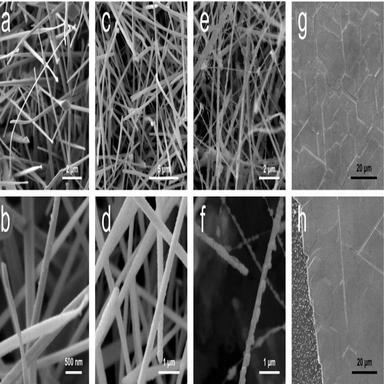
Scanning electron microscope images of (a,b) ZnOePbI2 NWs made using the thermal evaporation approach; (c,d) ZnO NWs covered by lead oxide deposited by magnetron sputtering; (e,f) ZnOePbI2 NWs made by converting the lead oxide coating; (g,h) PbI2 thin film made by converting a lead oxide film.